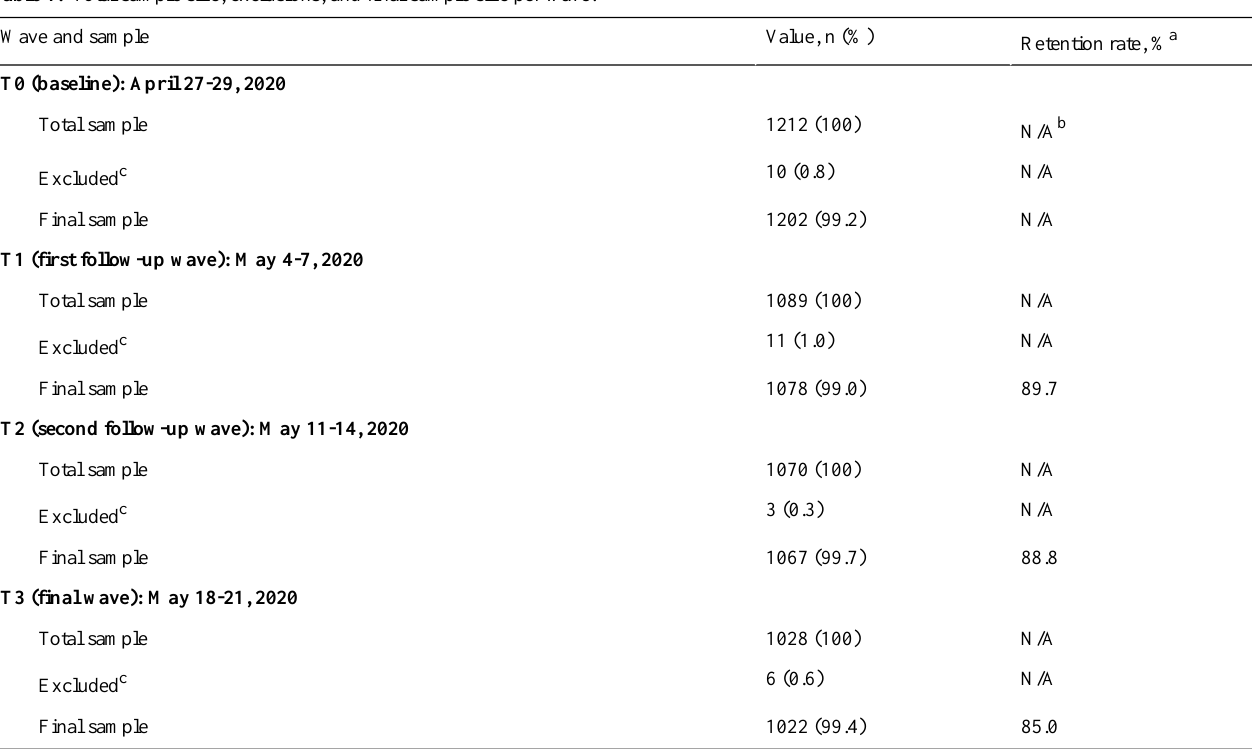
Table 1. Total sample size, exclusions, and final sample size per